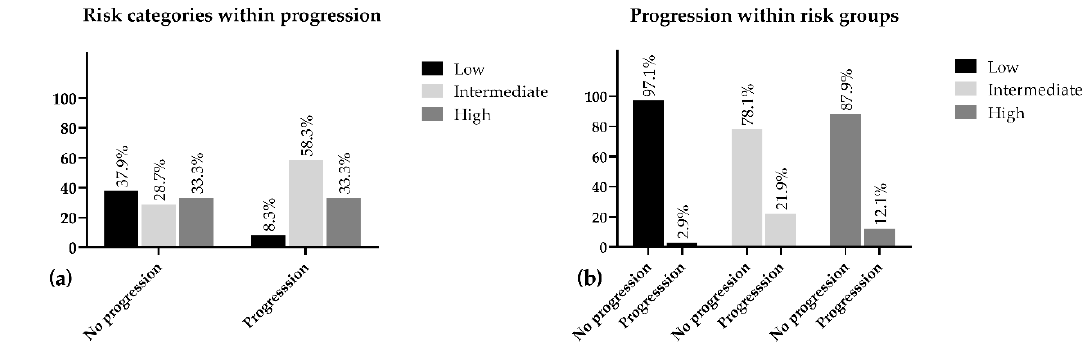
Figure 1. Percentage distribution of risk groups within progression ( a ) and progression within risk ( b ).